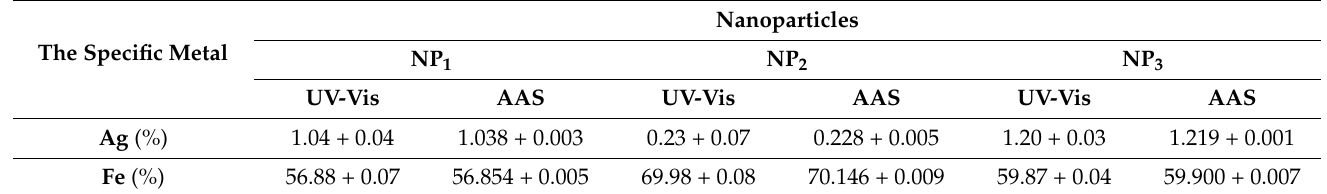
Table 5. UV-Vis and atomic absorption spectrophotometric analysis of nanoparticles.